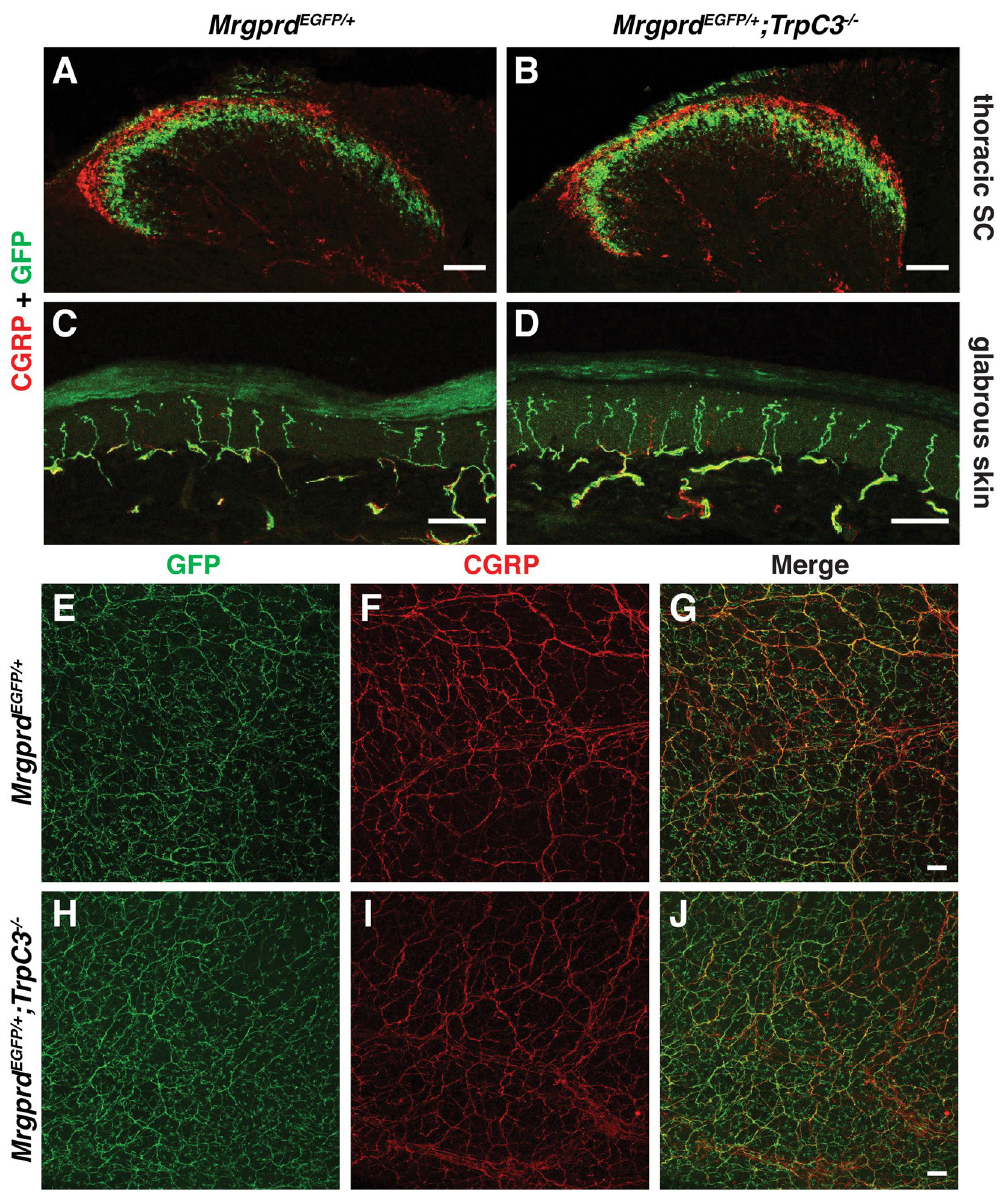
Figure 5. Gross anatomy of non-peptidergic nociceptors in the spinal cord and skin is normal in TrpC3 null mice. ( A and B ) Immunostaining in P21 Mrgprd EGFP/ + and Mrgprd EGFP/ + ; TrpC3 − / − mouse thoracic spinal cord sections using antibodies against CGRP and GFP. ( C and D ) Immunostaining in P21 Mrgprd EGFP/ + and Mrgprd EGFP/ + ; TrpC3 − / − mouse glabrous skin cross sections using antibodies against CGRP and GFP. ( E – J ) Immunostaining in P21 Mrgprd EGFP/ + and Mrgprd EGFP/ + ; TrpC3 − / − mouse whole mount glabrous skin using antibodies against CGRP and GFP. No obvious differences are seen in spinal cord and peripheral nerve endings between WT and TrpC3 KO backgrounds. N = 3 mice for each genotype. Scale bars = 50 μ